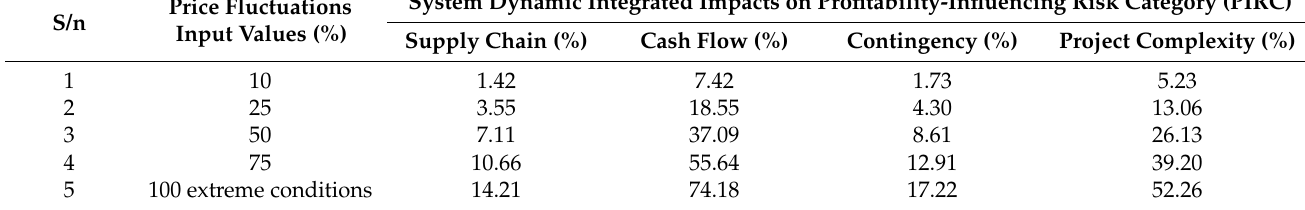
Table 6. Results of system dynamic modeling and